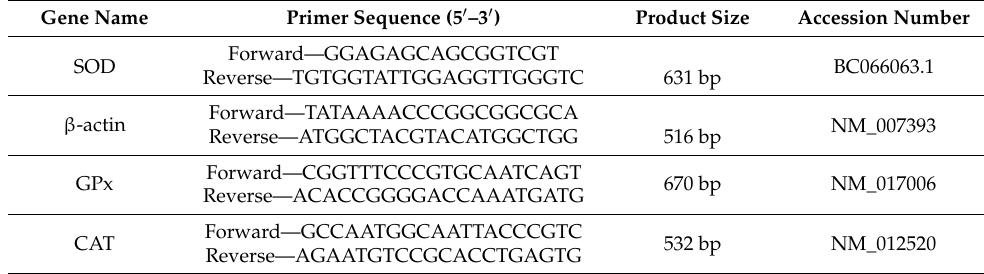
Table 1. PCR primers and methods for the tested